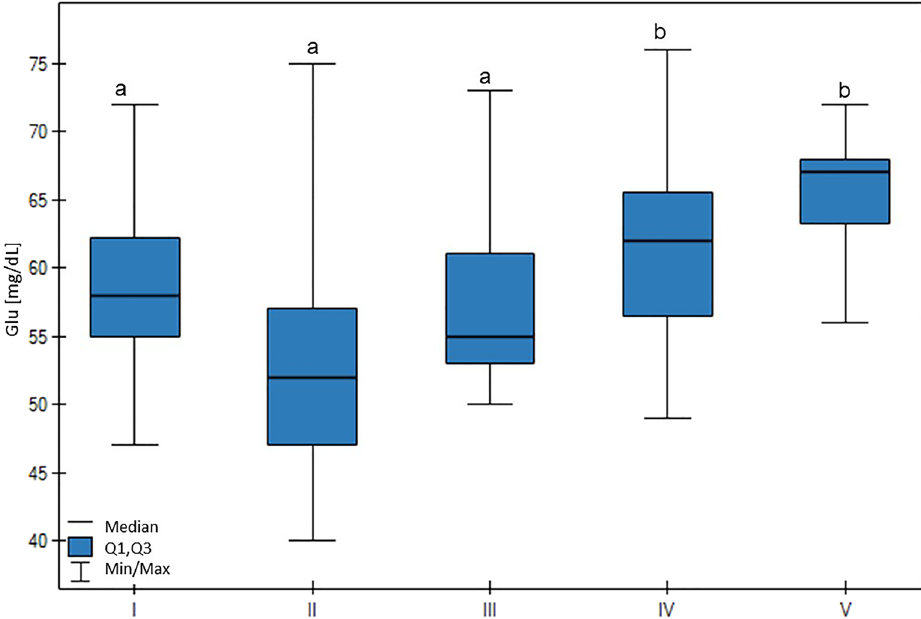
Figure 6. Differences in Glu (glucose) values in cows at different production levels. In the box plots, the upper whisker represents the maximum value; the upper line of the box represents Q3 (upper quartile); the center line inside the box represents the median; the lower line of the box represents Q1 (lower quartile); and the lower whisker represents the minimum value. Groups marked by letters (a–b) differ significantly, p ≤ 0.05. The cows were divided in to five groups: I—44–39 kg milk/cow; II—38–31 kg milk/cow; III—30–26 kg milk/cow; IV—25–20 kg milk/cow; and V—19–17 kg milk/cow, based on mean daily milk